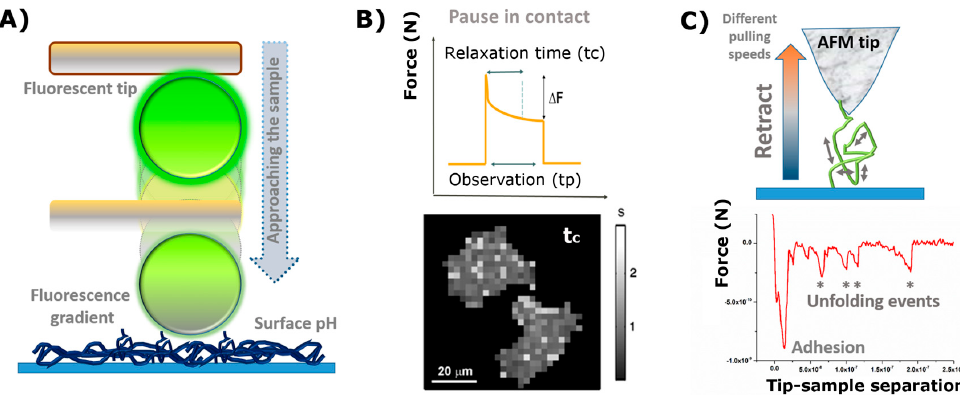
Figure 4. Potential uses of atomic force microscopy (AFM) according to the focus on each of the individual three main segments of a force-distance curve (note that time is an implicit variable in a force-distance curve and therefore can be also represented as a force-time curve). ( A ) Scheme of Fluorescence-based surface pH sensor mode, in which a stained colloidal probe is approached to the surface of interest. At sufficiently close distances the change in the pH induces quenching of the fluorescence emission (changes in surface pH as a function of time can be detected in “pause in contact mode”). ( B ) An example of Stress Relaxation imaging mode obtained on MCF-7 cells from mapping their relaxation time ( t c ) values, in seconds, according to the coloured scale on the right ( adapted reprint from [97] with permission of the authors ). The plot on top represents the usual shape obtained for a stress relaxation experiment, keeping the contact in constant height, where ∆ F denotes the force decay and t p and t c refer to the observation and relaxation times, respectively. ( C ) Scheme of a single chain pulling experiment. The pulling rate (speed) can be adapted to demand. Below, a representative retraction plot showing the most relevant unfolding events measured and the adhesion force peak.